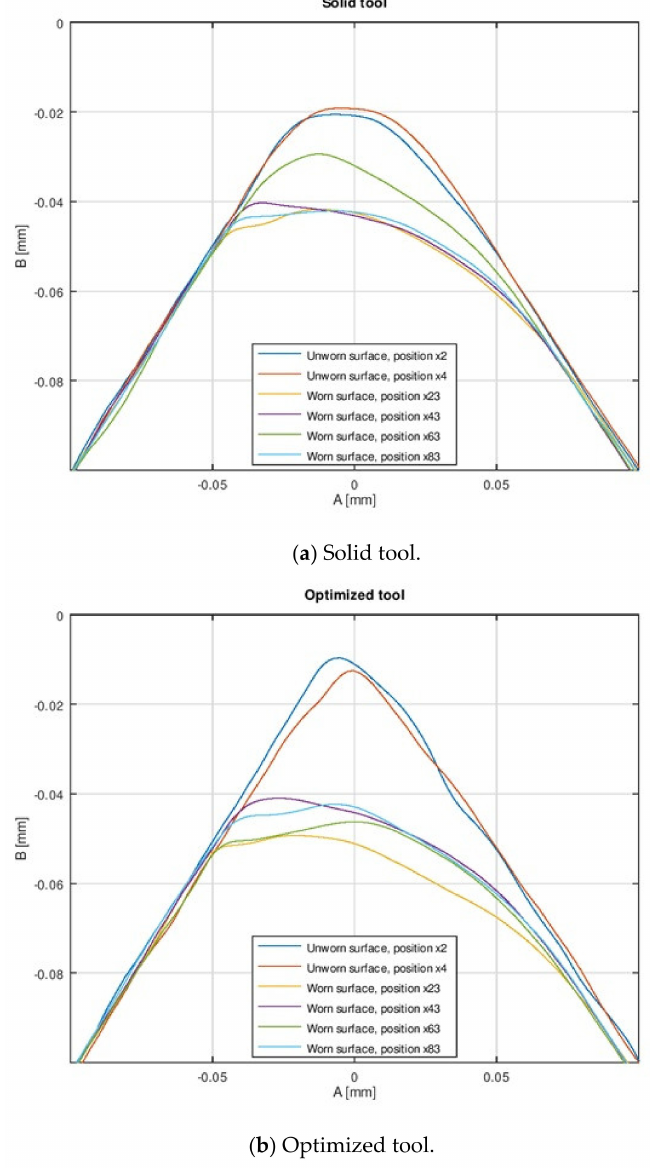
Figure 12. The wear after 100,000 strokes at the edge (profile) radius on the trim dies